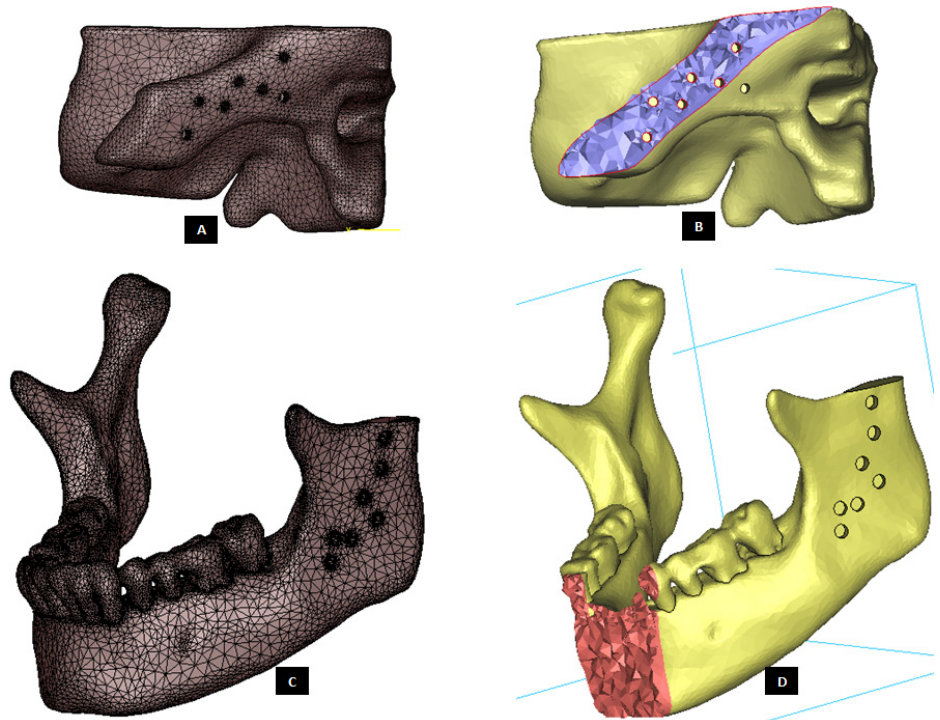
Figure 26. Three-D finite element mesh of the host bone components prepared for total prosthetic replacement of the left TMJ. ( A ) Shows FE surface mesh of left fossa, and ( B ) shows a lateral cross- section of the 3D volume mesh of left fossa bone with screw holes. Similarly, ( C , D ) show surface mesh and anterior cross-section of volume mesh, respectively, of the mandible with screw holes and removal of damaged left condyle.